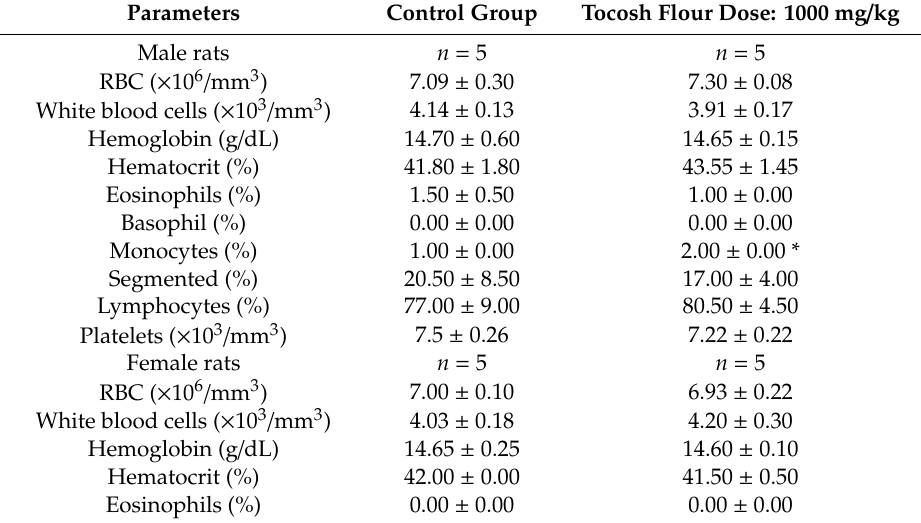
Table 3. Hematological evaluation of rats after administration of repeated oral doses of tocosh flour at doses of 1000 mg / kg for 28